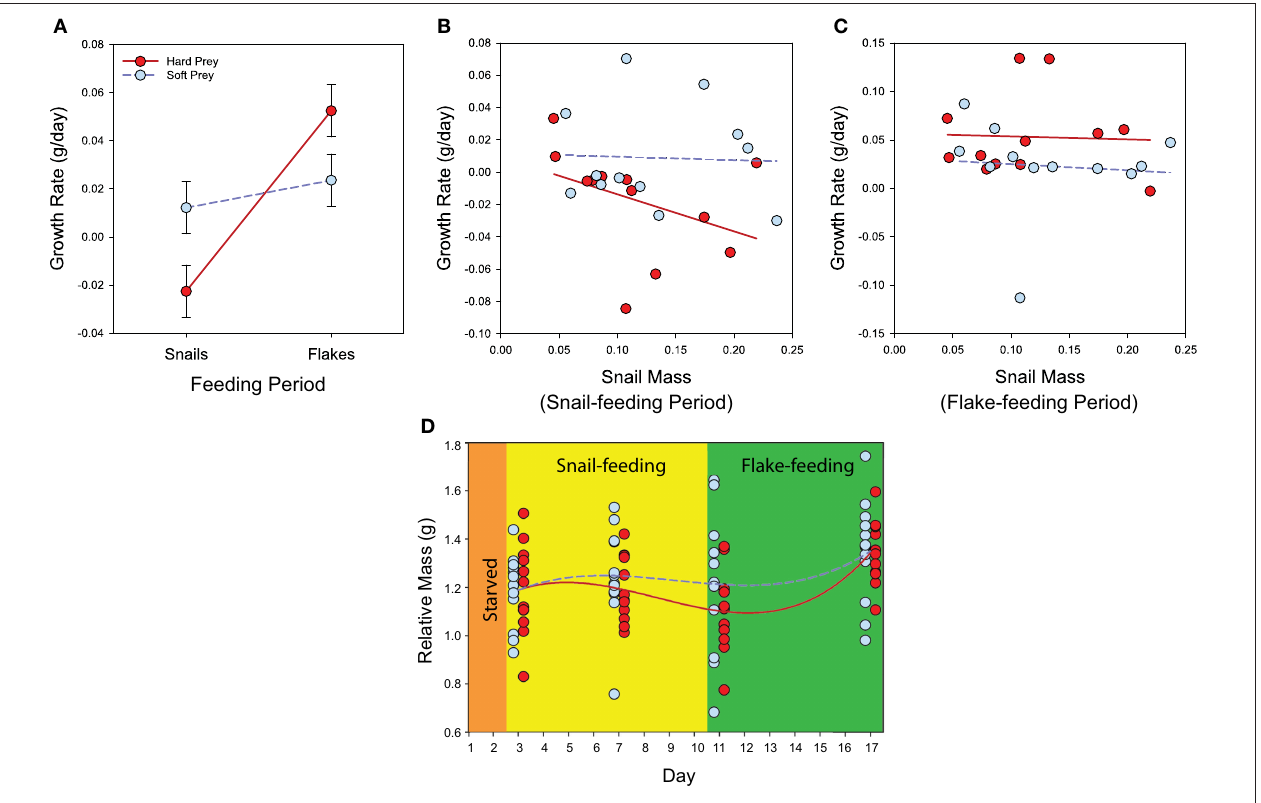
FIGURE 6 | Feeding experiment results in Gambusia holbrooki illustrating (A) differences in growth rate between hard- and soft-prey treatments during both snail-feeding and flake-feeding periods (least-squares means ± 1 standard error), (B,C) relationship between snail weight fed to fish and growth rate for both hard- and soft-prey treatments during (B) the snail-feeding period and (C) the flake-feeding period, and (D) overall pattern of mass change (relative to body length) during the